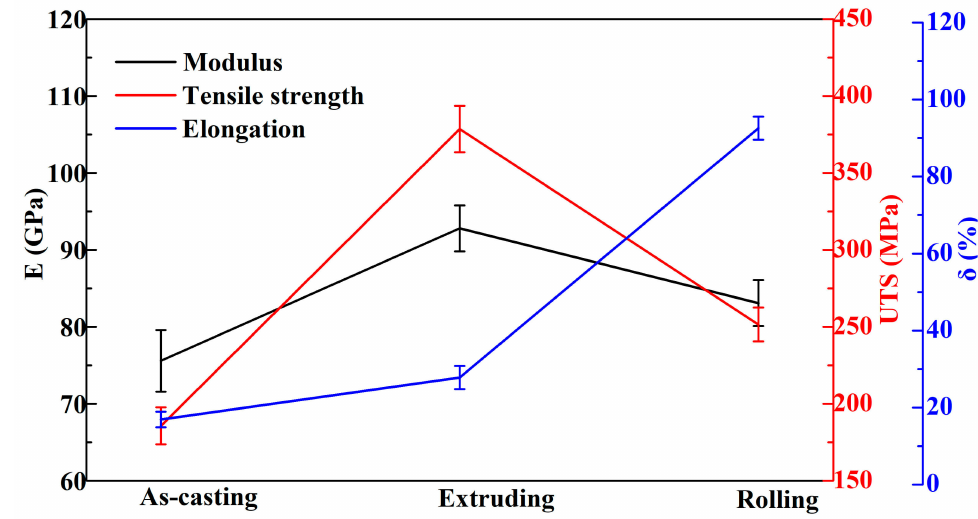
Figure 6. Mechanical properties of the Zn-0.5%Li-0.1%Ag alloy in different treatment